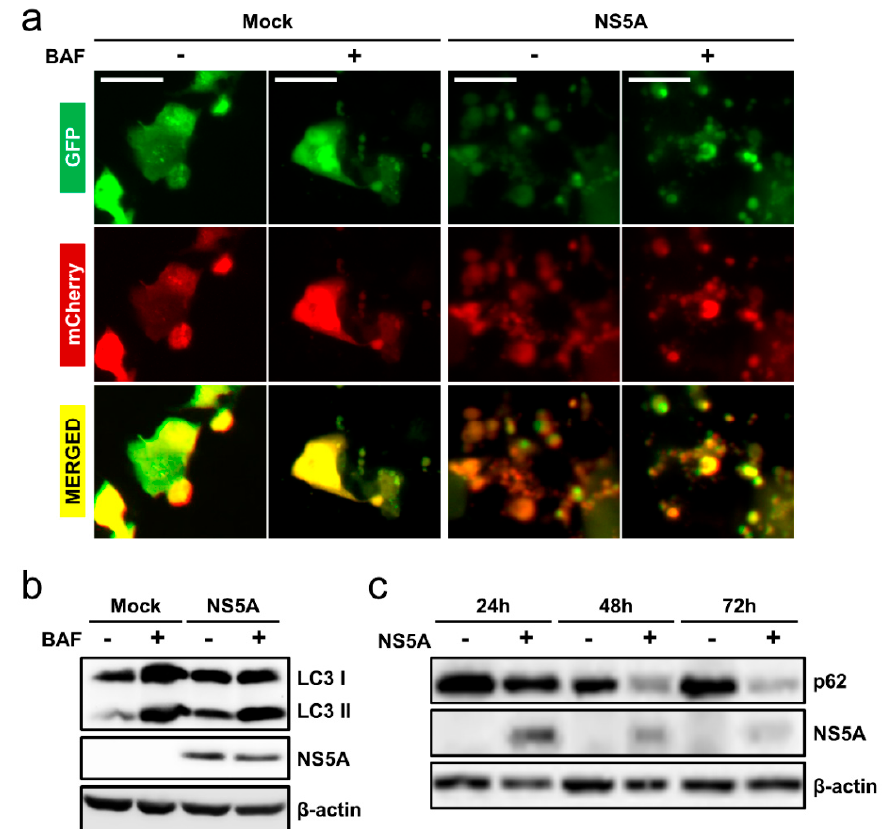
Figure 4. NS5A induces complete auto/mitophagy. ( a ) Huh-7.5 cells were seeded in 12-well plates and co-transfected with mCherry-EGFP-LC3 and NS5A or mCherry-EGFP-LC3 only (mock). The cells were incubated for 48 h, after which they were treated with or without 0.2 µ M BAF for 12 h before fluorescence imaging. Magnification = 400 × ; scale bar = 20 µ m. ( b ) LC3-turnover assay. Huh-7.5 cells were mock- or NS5A-transfected for 48 h and then treated with or without 0.2 µ M BAF for 4 h before cell harvest for immunoblotting against LC3 and NS5A. ( c ) Analysis of p62 degradation in Huh-7.5 cells transfected with or without NS5A. The cell lysates were harvested at the indicated time-points and subsequently analyzed by Western blotting by probing with anti-p62 and anti-NS5A antibodies. β -actin served as a loading control for all analyses. Results shown are representative data from three independent experiments.